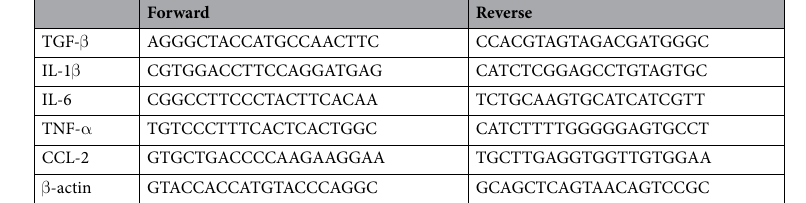
Table 1. Mouse primer sets used for qRT/PCR.